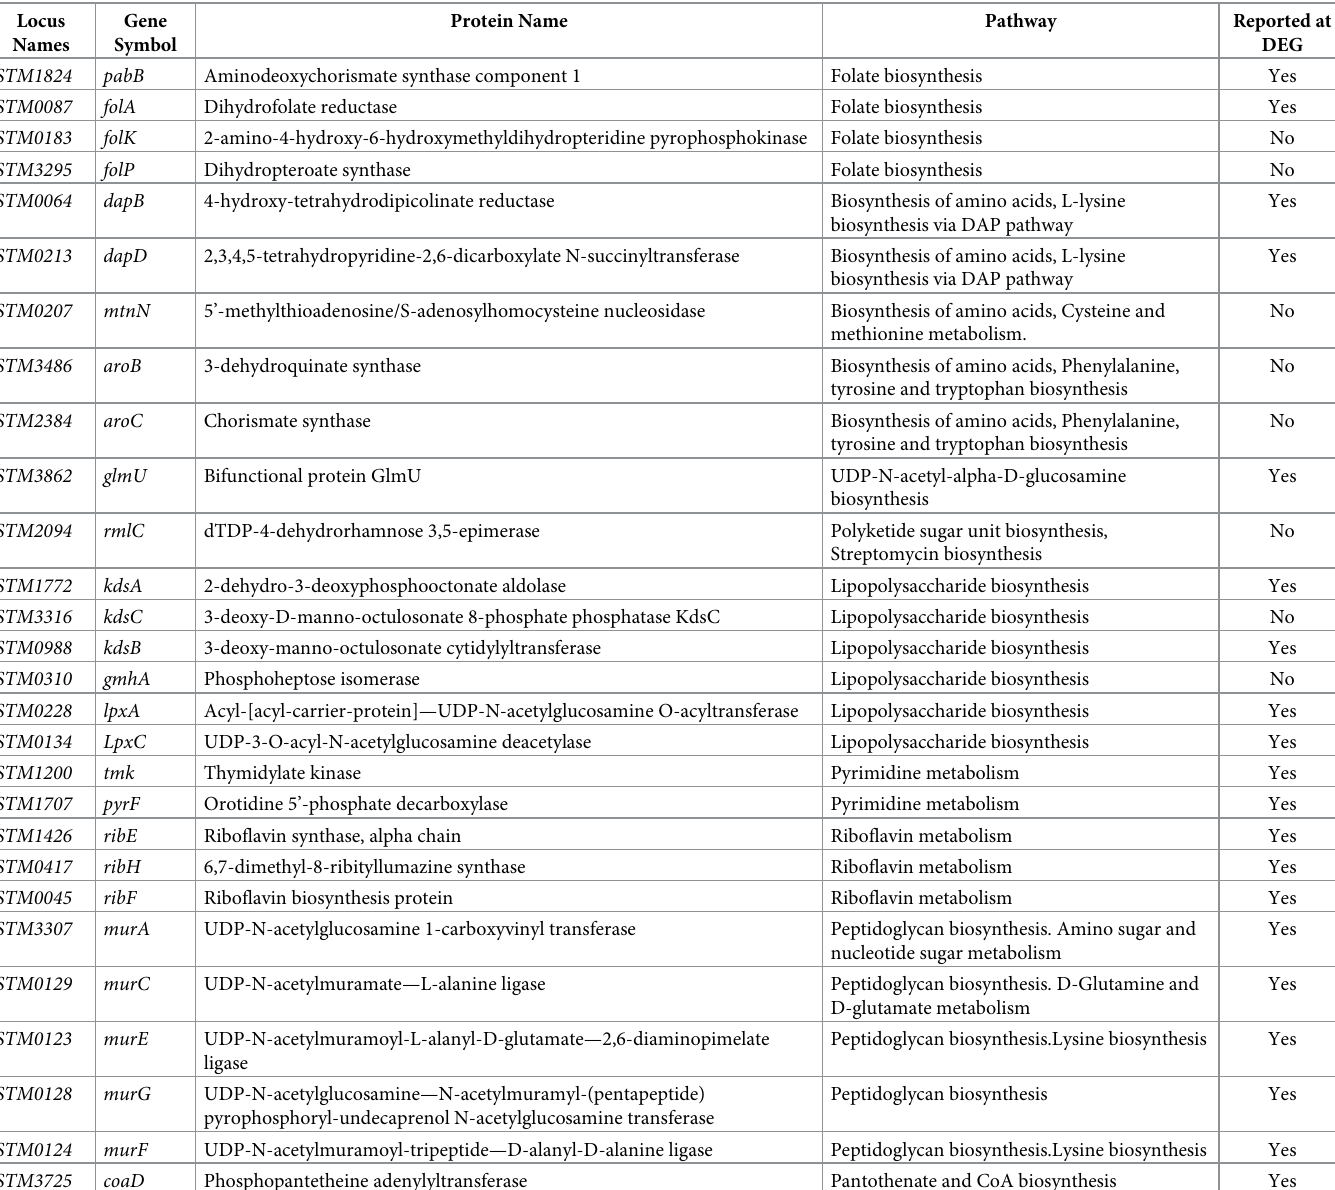
Table 3. Model-derived potential drug targets that obey three criteria: No homology to human proteins, druggable, and broad-spectrum